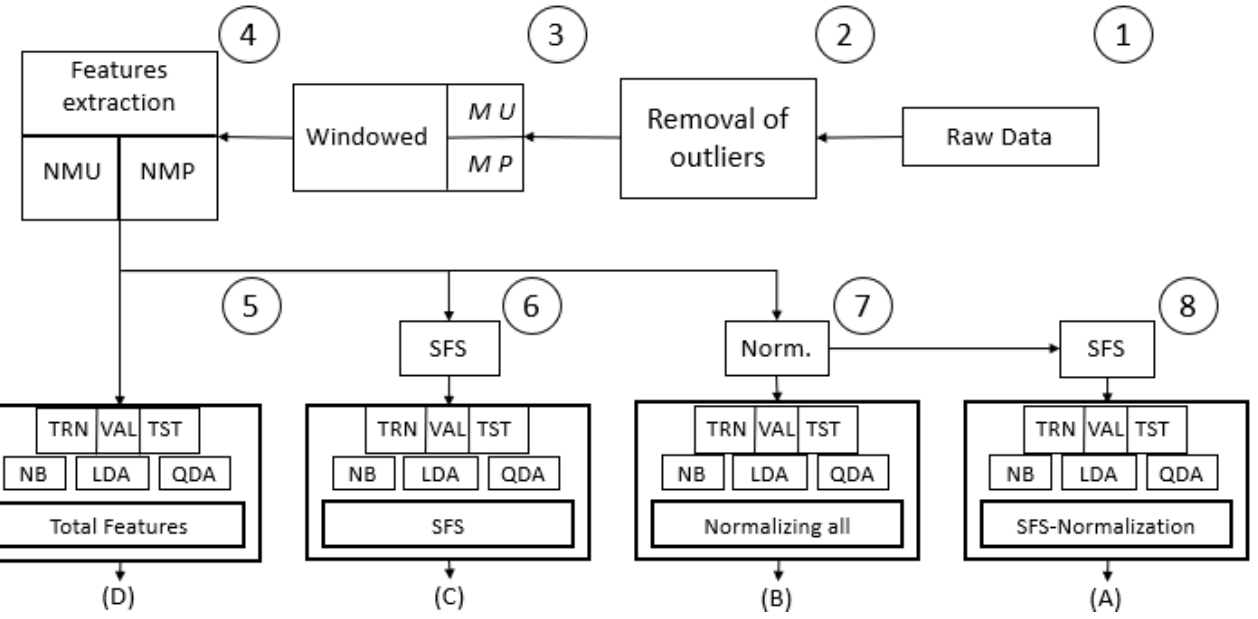
Figure 2. Experimentation conducted to determine the best option for creating a classification model considering recognition percentage and simplicity of the model. MU = single matrix (all eight subjects concatenated), MP = matrix per subject (eight matrices are formed). The number of circles defines the order of processing. The nomenclature ( A – D ) serves for Duncan’s significance test treatment identification that compares the output of each experiment.